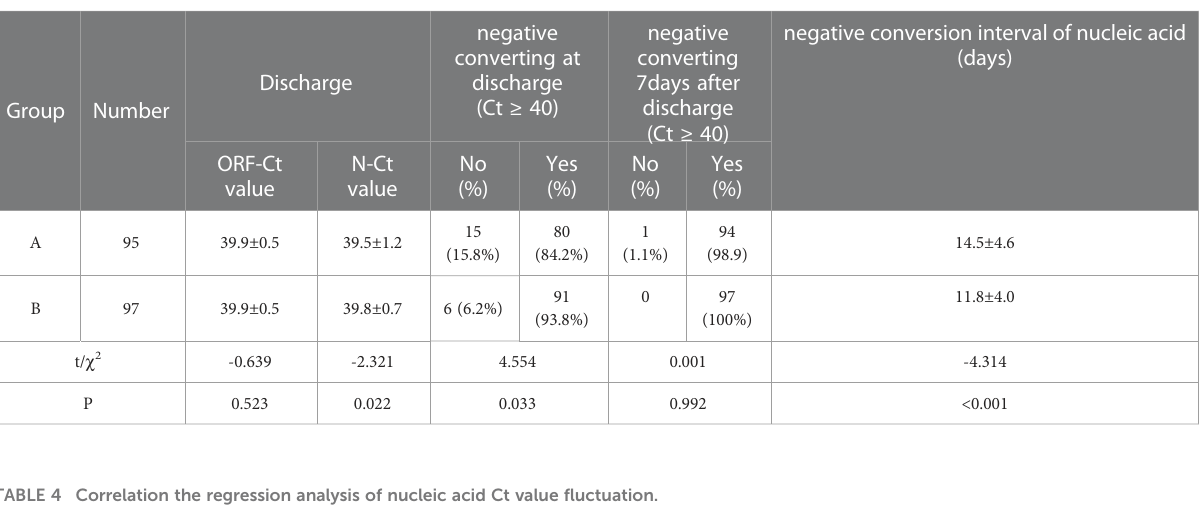
Complicated with chronic internal disor- ders